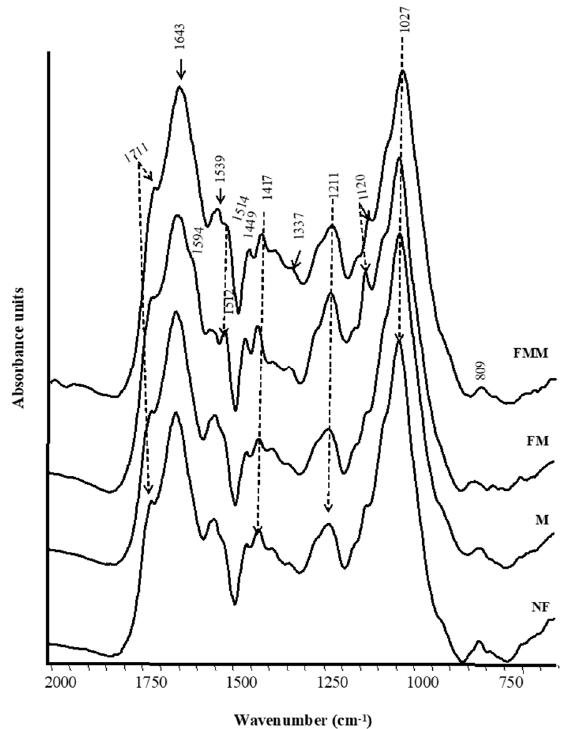
Figure 2. FT-IR spectra of humic substances (HS) extracted from earthworm coprolites collected in soils fertilized with no inputs (NF), or with manure (FM), mineral fertilizers (M) and with manure plus mineral fertilizers (FMM).